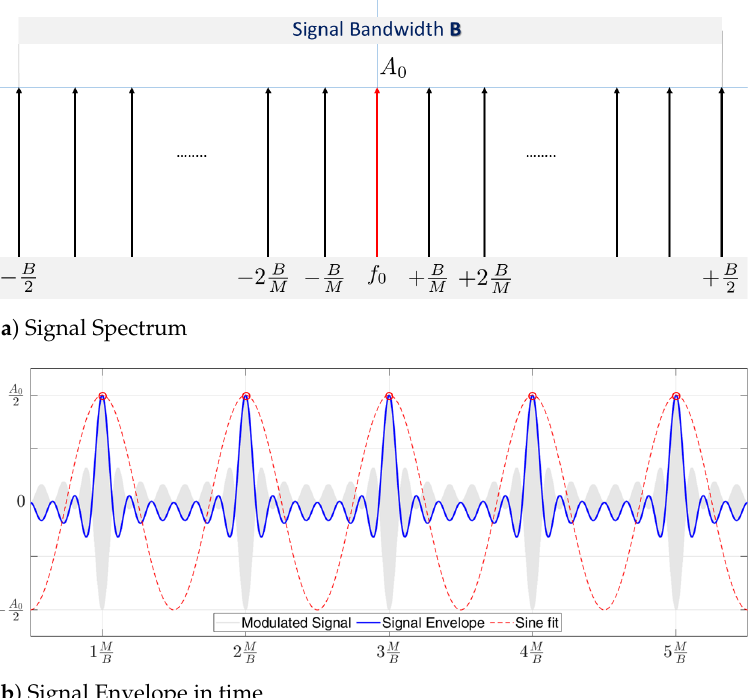
Figure 2. Example of a generic multi-tone signal with constant tones amplitude and Sine